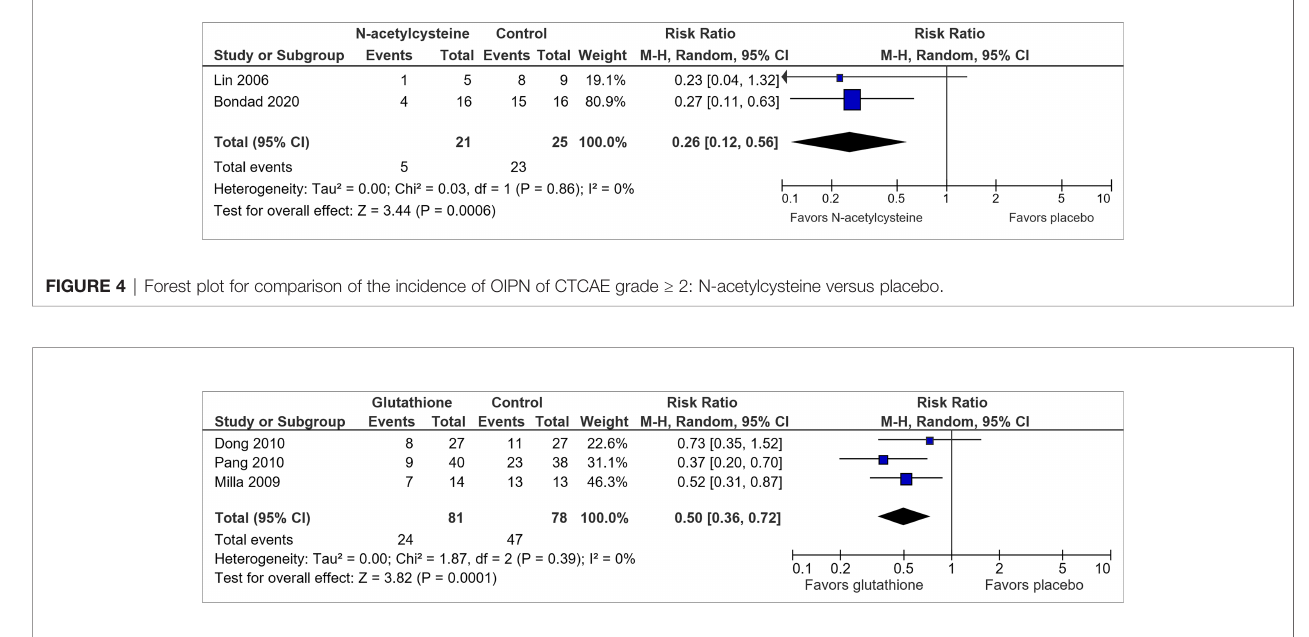
FIGURE 5 | Forest plot for comparison of the incidence of OIPN of CTCAE grade ≥ 2: Reduced glutathione versus